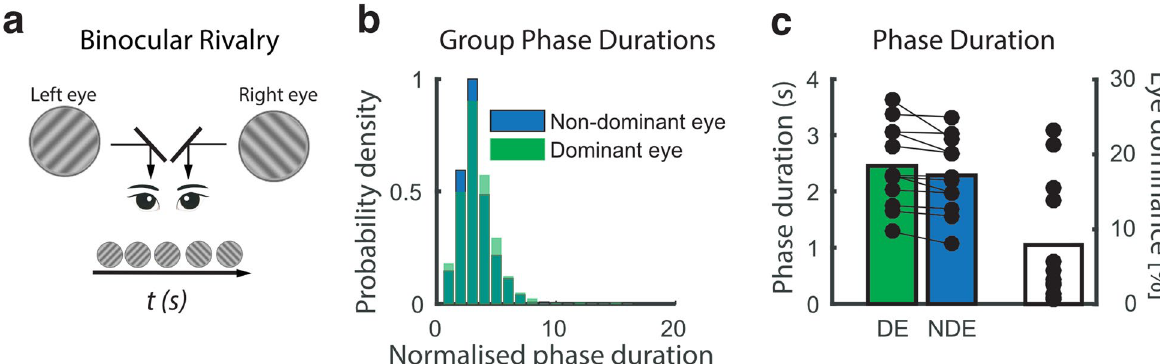
Figure 1. (a) Sensory eye dominance was measured in a binocular rivalry experiment outside of the scanner. Stimuli were presented on a mirror stereoscope and participants reported their subjective percept using a continuous key press. (b) Histograms of phase distributions for the dominant (DE, green) and non-dominant (NDE, blue) eye were pooled across participants. Data were normalised by the median dominant eye phase duration. (c) Average phase durations in seconds for DE (green) and NDE (blue) are plotted on the left. On the right are the biases in phase duration quantified for each participant by calculating the difference between